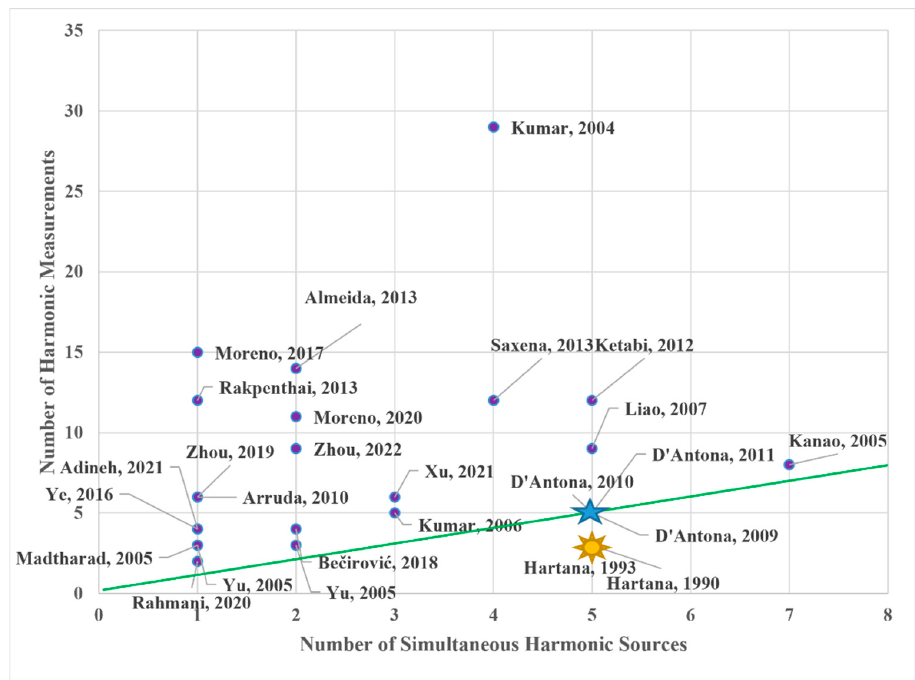
Figure 1. Number of simultaneous harmonic sources vs. number of harmonic measurements for HSE methods described in the literature: purple dots (overdetermined systems), the star (critically determined systems) and the sun (underdetermined systems) [2–12,14–22,24–27,29,31].